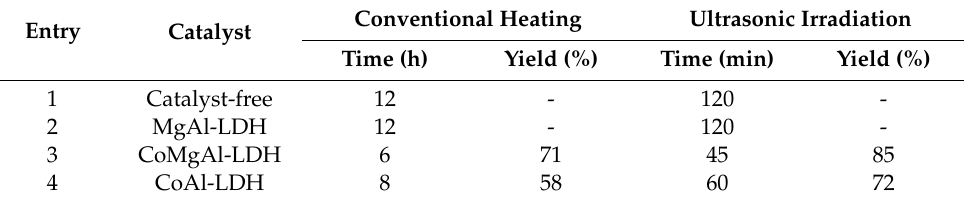
Table 2. Synthesis of compound 3 using di ff erent catalysts under ultrasonic irradiation.